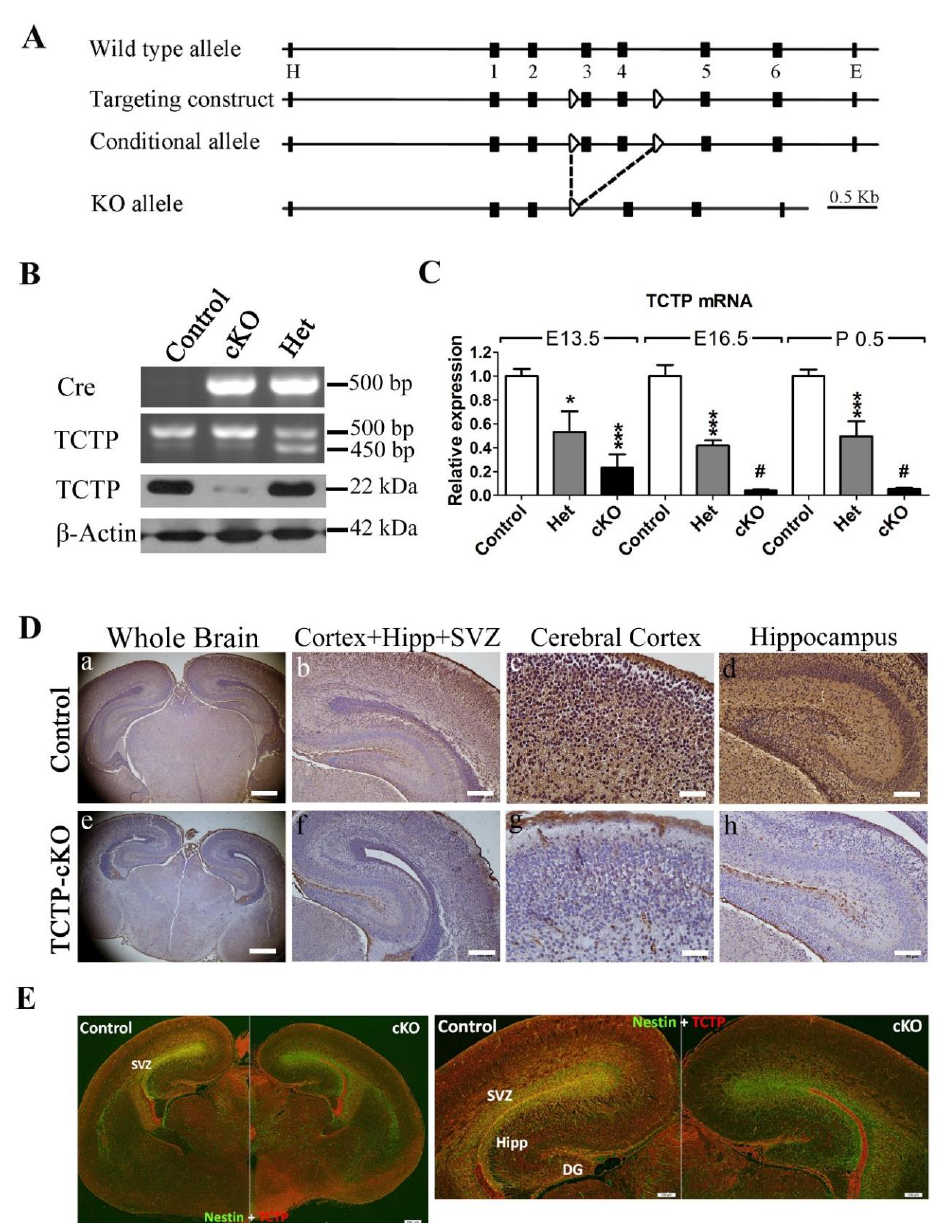
Figure 2. Generation of conditional TCTP knockout mouse model. ( A ) Diagram of the targeting strategy for the generation of the conditional TCTP allele. The targeting construct contains loxP sites (arrowheads) flanking exons 3–4 and restriction sites EcoRI (E) and HindIII (H). ( B ) Genotyping with PCR, top panel, and Western blotting of TCTP expression, bottom panel, from Nestin +/+ ; TCTP flox / flox (Control), Nestin Cre /+ ; TCTP flox / flox (heterozygous), and N estin Cre /+ ; TCTP flox /+ (cKO) mice at P0.5. ( C ) qRT-PCR of relative TCTP mRNA expression in the whole brain from control, heterozygous, and conditional knockout mice at different stages was estimated (data presented as mean ± SEM, * p < 0.05, *** p < 0.001 compared with control, # < 0.05 compared with E13.5 cKO, one-way ANOVA, n = 3–11 per group). ( D ) Immunohistochemistry of TCTP protein from control and TCTP-cKO mice at P0.5. DG, dentate gyrus; Hipp, hippocampus; SVZ, subventricular zone. Scale bars: a, e, 400 μm; b, f, 200 μm; c, g, 40 μm; d, h, 100 μm. ( E ) Sections at E16.5 were also detected by double-labeled immunofluorescence with antibodies against TCTP to identify the deletion and Nestin to identify neural precursor cells. A representative image is shown for three independent experiments. Scale bars: 100 µ m for right panel, 200 µ m for left